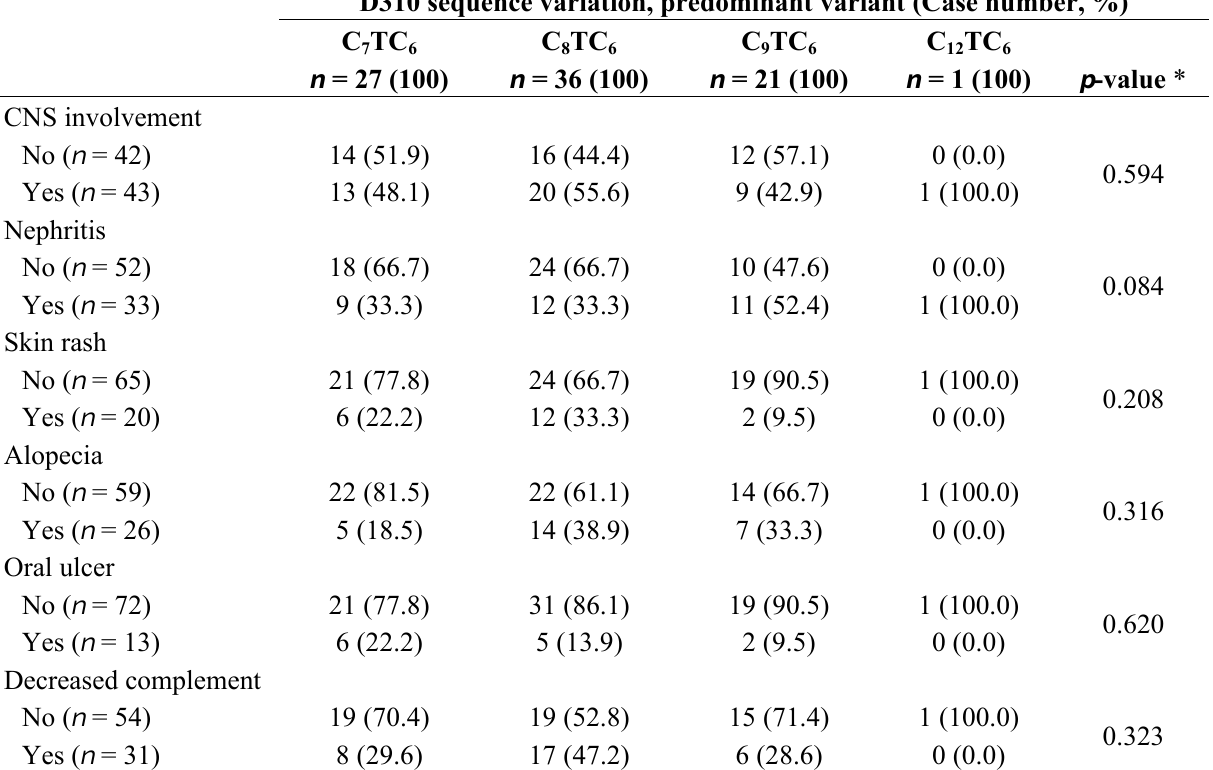
Table 4. Association of the D310 sequence variations of mtDNA with different clinical manifestations in SLE